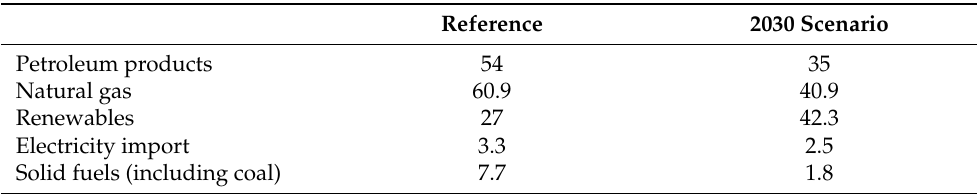
Table 1. Primary energy consumption (Mtoe).